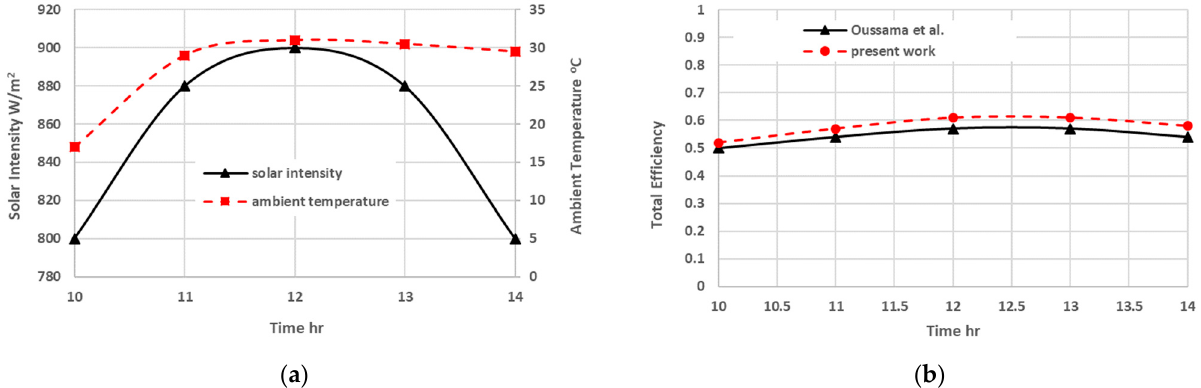
Figure 6. ( a ) Weather conditions of Oussama [18] ( b ) Comparison of the total efficiency of the present work and Oussama [18].